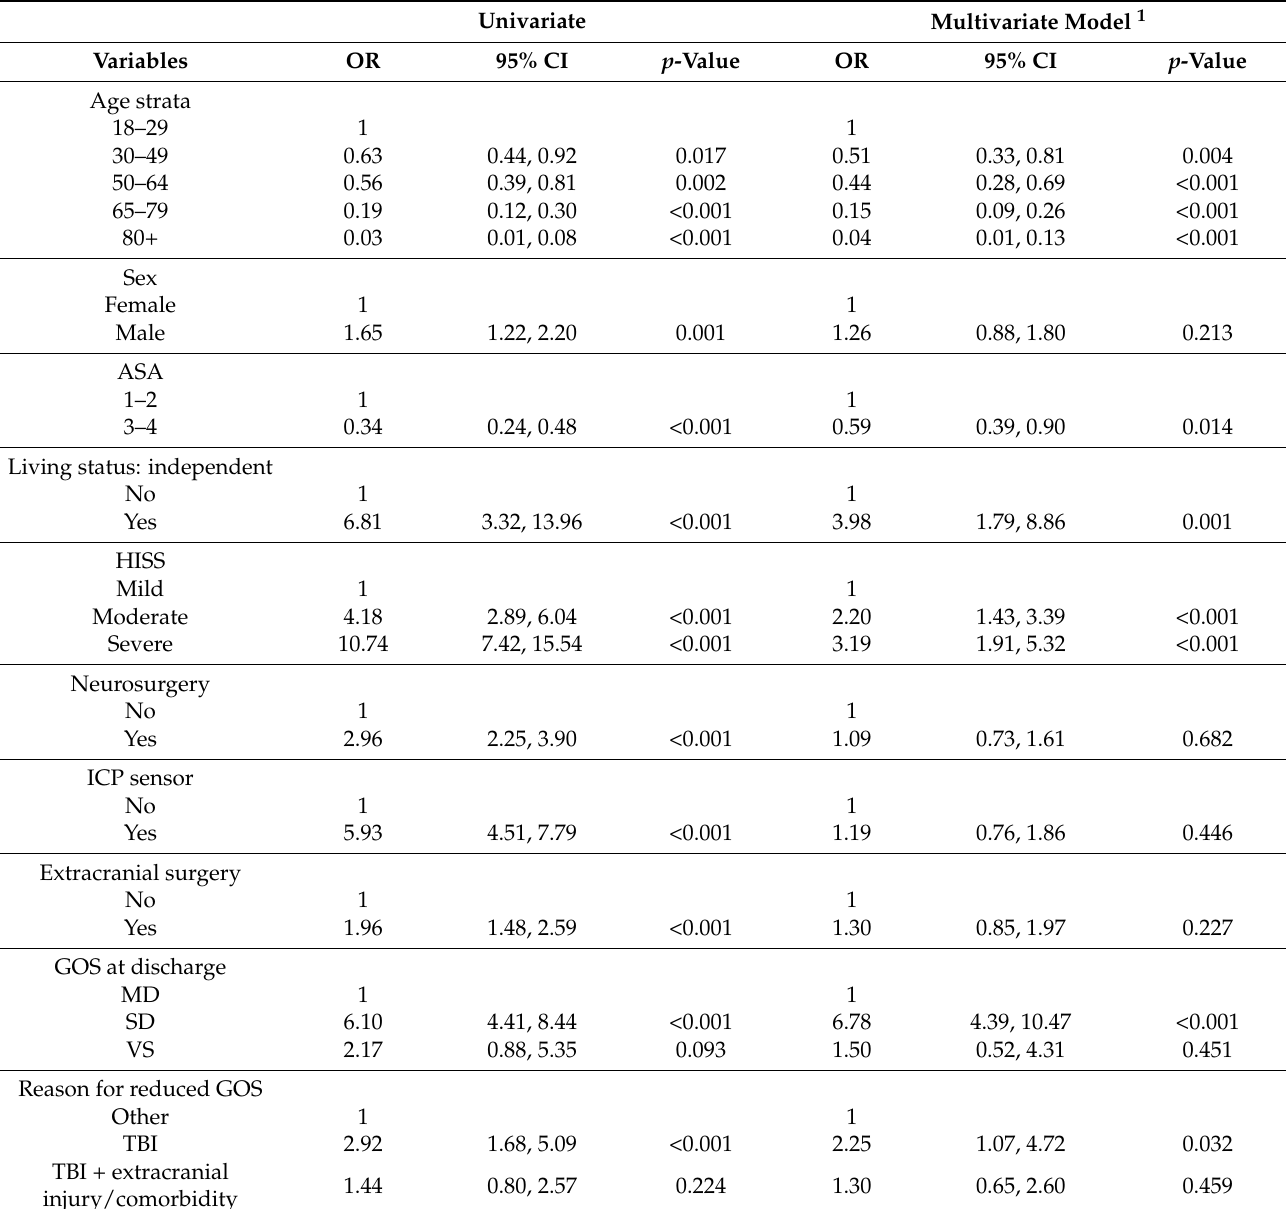
Table 4. Predictors associated with discharge directly to a rehabilitation unit ( n = 1724). A total of 1637 patients were included in the model; 87 were excluded (83 patients’ GOS 5-GR, 4 patients’ GOS not available).